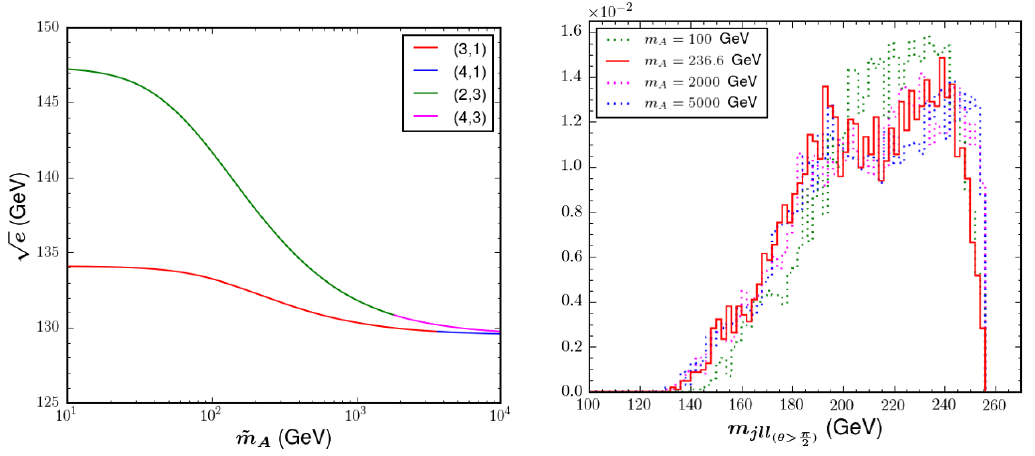
Figure 8 . The same as (cid:12)gure 7, but for the endpoint p e and the corresponding distribution m jll ( (cid:18)> (cid:25) 2 )